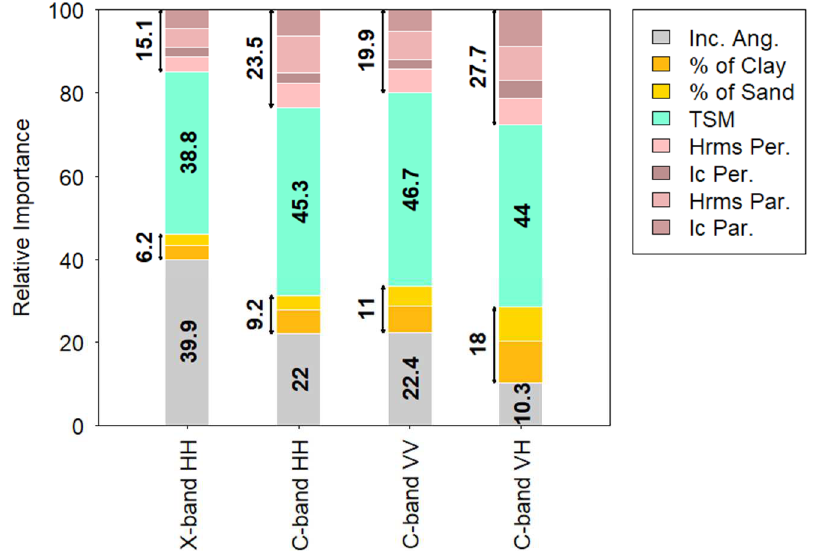
Figure 10. Comparison of the importance (expressed in percent) of the input parameters (incidence angle and soil descriptors) considering the RF algorithms in the X-band and C-band in the 3 polarizations states (HH, VV and VH).